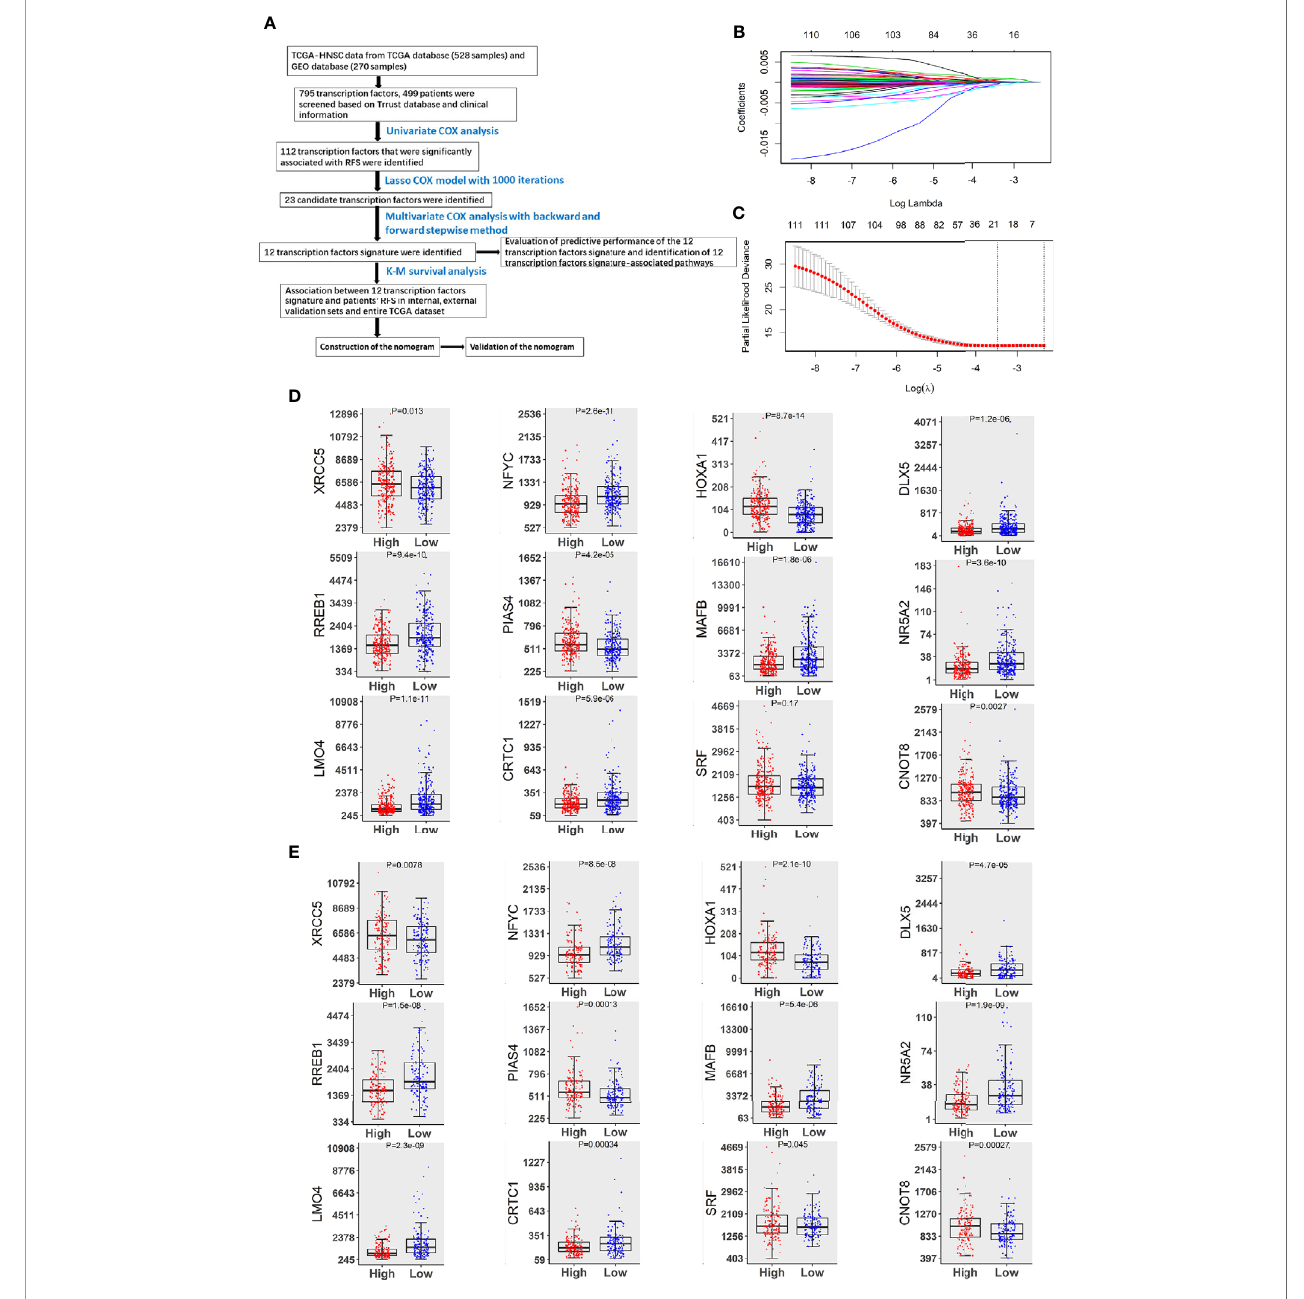
FIGURE 1 | Identi fi cation of TFs predicting RFS in patients with HNSCC. (A) The fl ow chart of how to identify TFs associated with RFS in HNSCC. (B) 10-fold cross-validation for tuning parameter selection in the LASSO model by minimum criteria (the 1-SE criteria). (C) LASSO coef fi cient pro fi les of the 112 TFs genes. A coef fi cient pro fi le plot was conducted against log (lambda) sequence. Vertical line was drawn at the value selected with 10-fold cross-validation, in which optimal lambda led to 23 non-zero coef fi cients. (D) Boxplots of the 12 TFs expression values against risk group in the TCGA dataset. “ High ” and “ Low ” referred to the high- risk and low-risk clusters, respectively. The differences between the 2 clusters were evaluated by Mann-Whitney U test, and P values were observed in the graphs. (E) Boxplots of 12 TFs expression values against risk cluster in the GEO